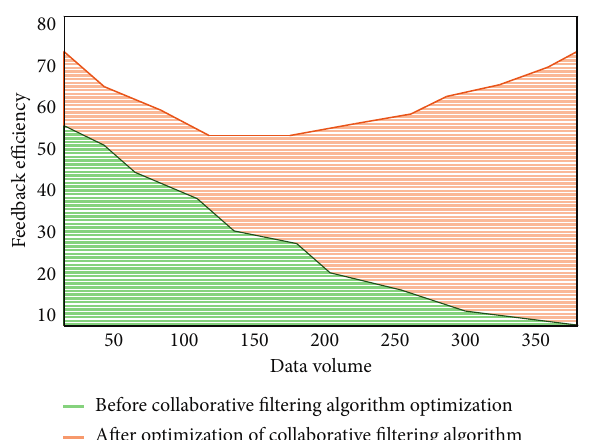
Figure 5: Comparison of feedback efficiency between traditional algorithm and optimized